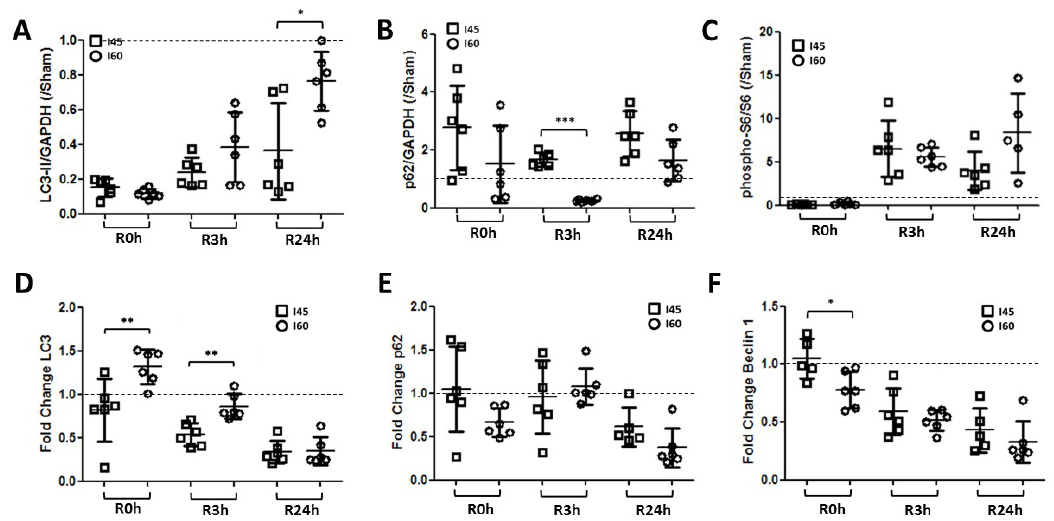
Figure 5. Autophagy is increased during ischemia and after reperfusion following severe ischemia compared to mild ischemia. Rats, either Sham-operated (Sham) or subjected to 45 min (I45) or 60 min (I60) of renal ischemia, were sacrificed at various time points post reperfusion (R0h, R3h, and R24h). Kidneys were collected and analyzed by Western blotting and qPCR for LC3 ( A ), p62 ( B ), S6, and phosphorylated S6 (pS6) ( C ), and by qPCR for the mRNA expression of LC3 ( D ), p62 ( E ), and BECN1 ( F ).The relative change in I45 and I60 compared to the corresponding Sham group (represented by the dashed line at y = 1) was plotted. * p <0.05, ** p < 0.01 , *** p < 0.001 . N = 6.